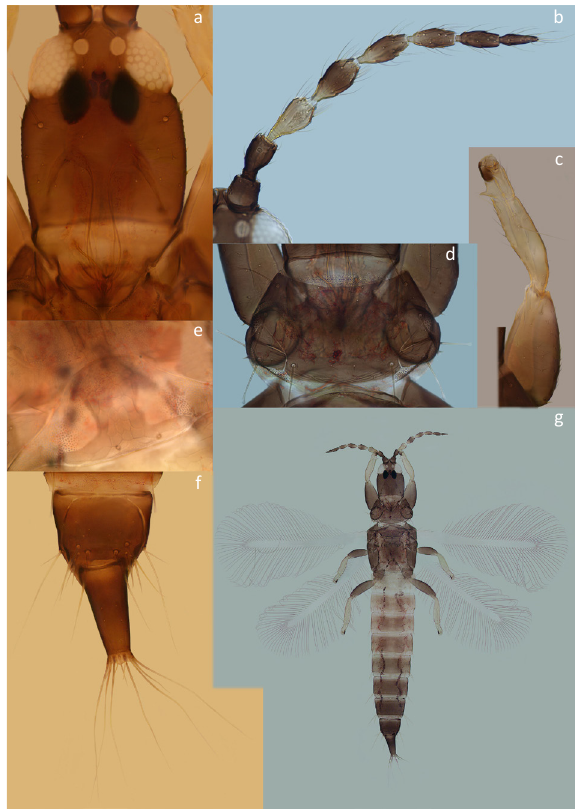
Total body length 1692. Head, length 196; width across the eyes 132; width across cheeks 148; width at